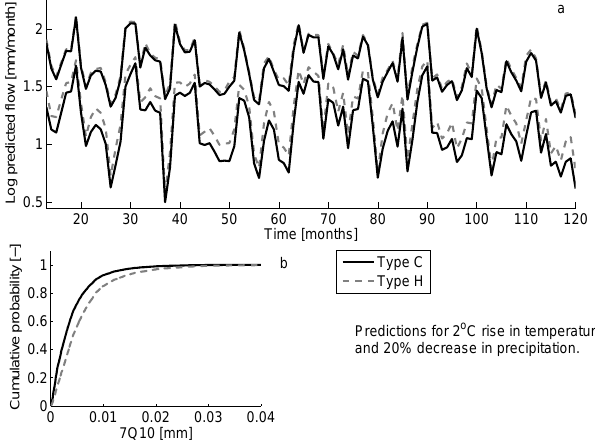
Fig. 5. (a) Monthly time series of predicted flow for a climate sce- nario of 20% decrease in precipitation and 2 ◦ C increase in tem- perature for the Escambia watershed. Dashed and continuous lines show the 90% prediction limits for Type H and Type C respectively. The flow has been log transformed to accentuate the difference be- tween low flows. The first year of simulated flows is the warm up period and is not plotted. (b) Cumulative probability of 7 day low flow with a return period of 10yr (7Q10) calculated for the Escam- bia watershed for identical climate scenario for Type H and Type C